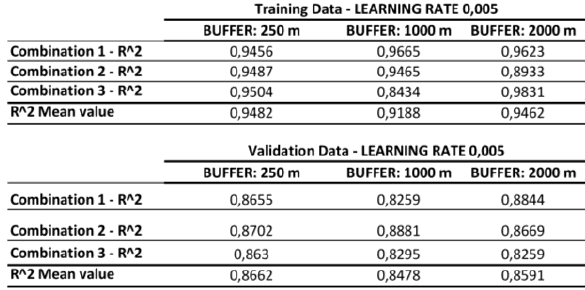
Tab. 2: Training and validation values of R^2 over the K-folds using Learning Rate